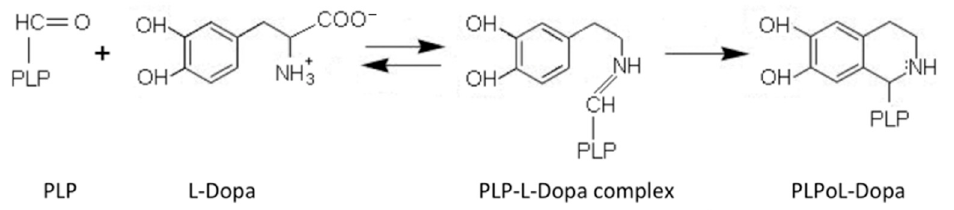
Figure 2. Pictet–Spengler reaction of pyridoxal 5 ′ -phosphate (PLP). Scheme of the condensation reaction between PLP and L-Dopa generating the Pictet–Spengler adduct.